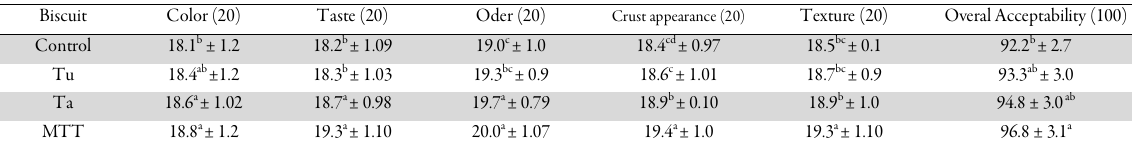
Table 7. Sensory evaluation of colored wheat flour biscuit made using different levels of turmeric and tartrazine powder Biscuit Color (20) Taste (20) Oder